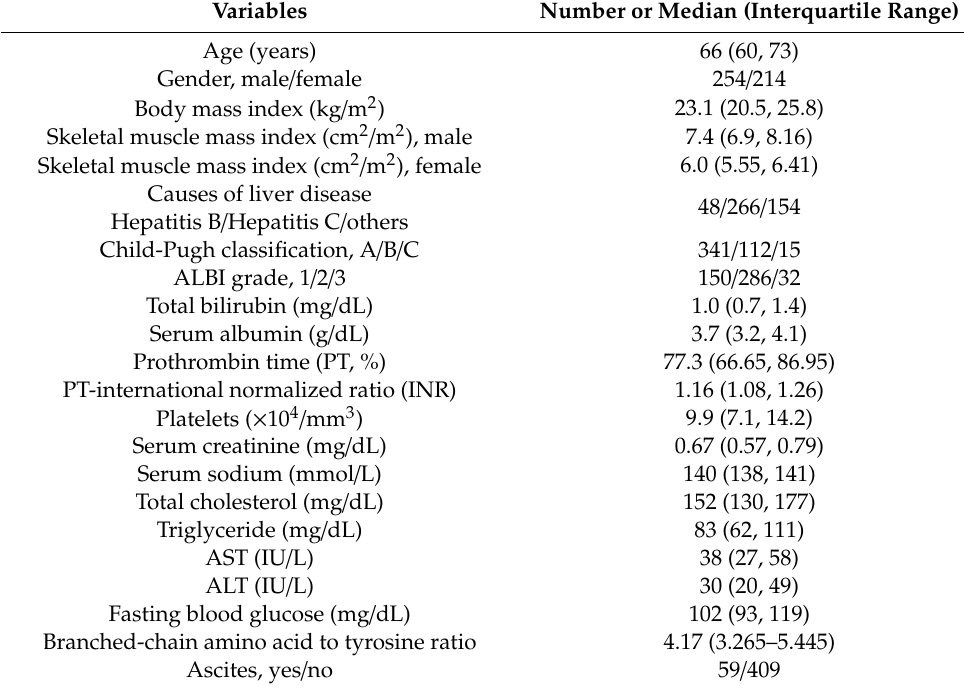
Table 2. Baseline data ( n = 468).